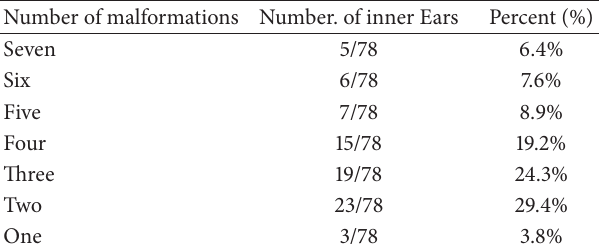
Table 2: Distribution of malformations. Number of malformations Number. of inner